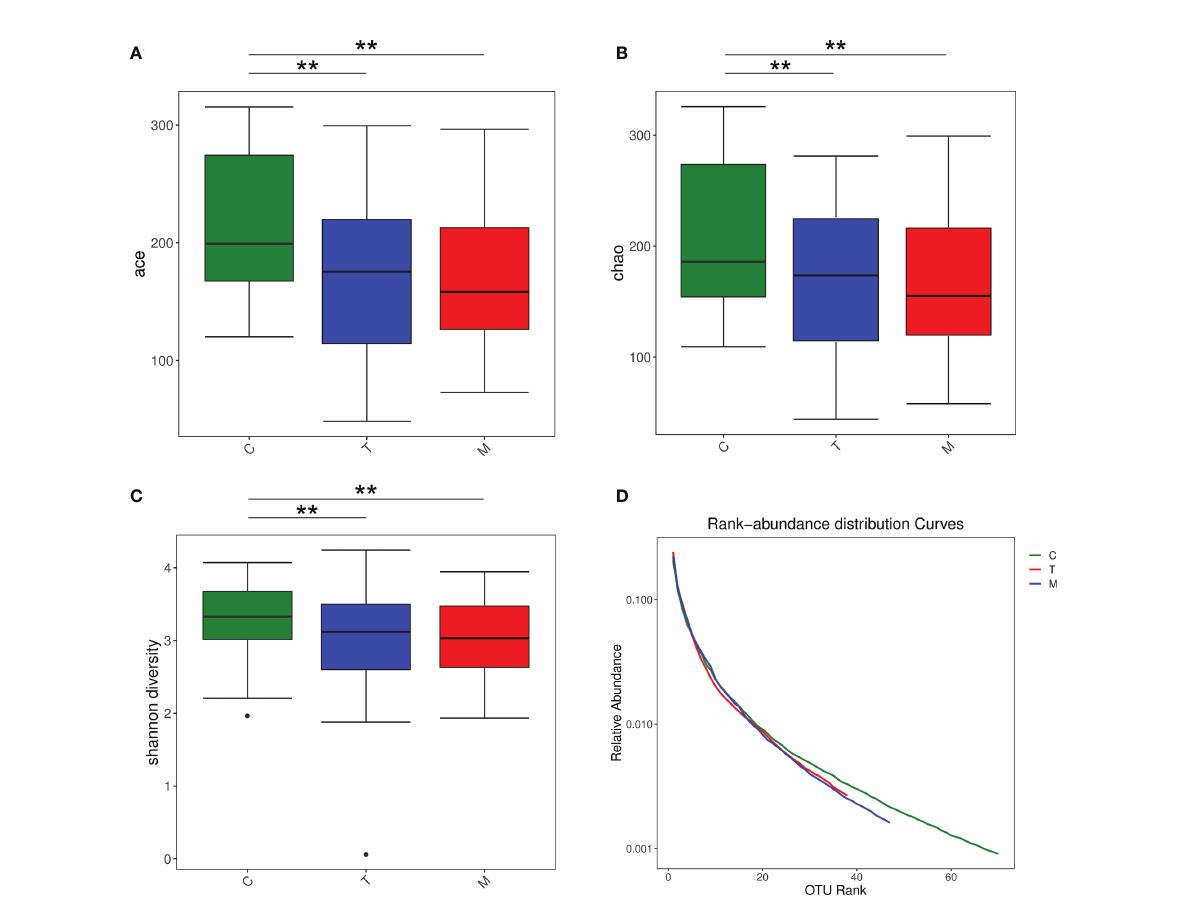
FIGURE 3 Boxplot of the Kruskal -Wallis test for the Ace index (A) , Boxplot of the Kruskal -Wallis test for the Chao index (B) , Boxplot of the Kruskal -Wallis test for the Shannon index (C) , Rank-abundance distribution curves of the general control group and the experimental groups (D) . **p <